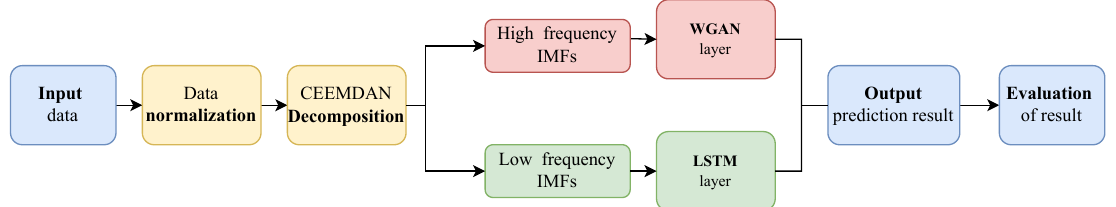
Figure 4. The overall flow chart of all proposed GHI prediction